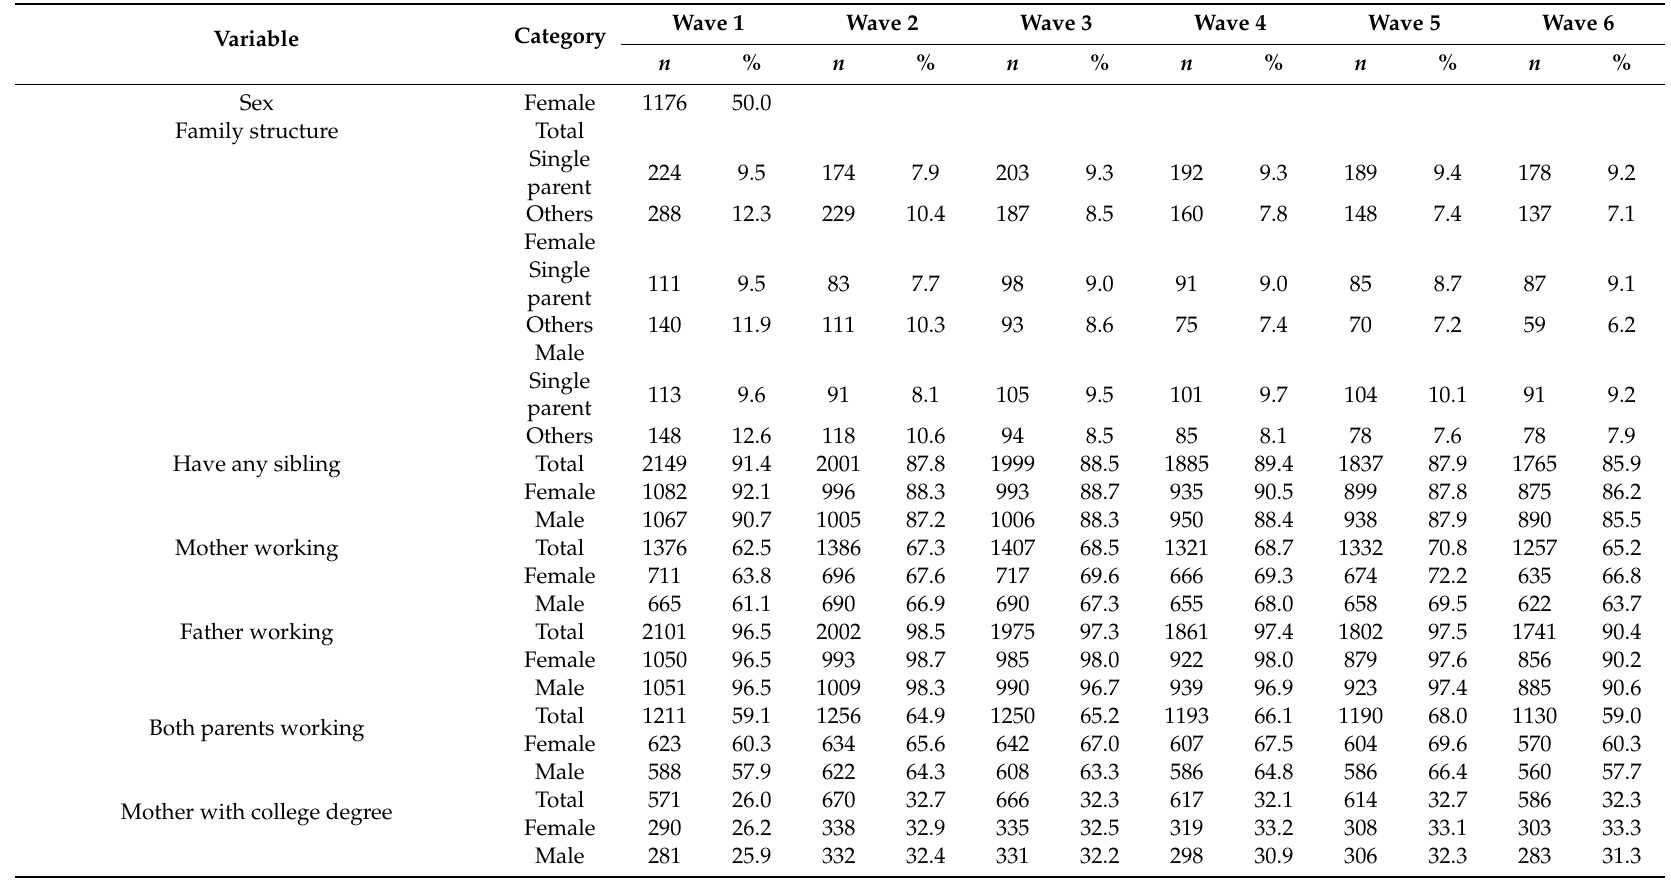
Table 1. Characteristics of the sample of adolescent students ( n =